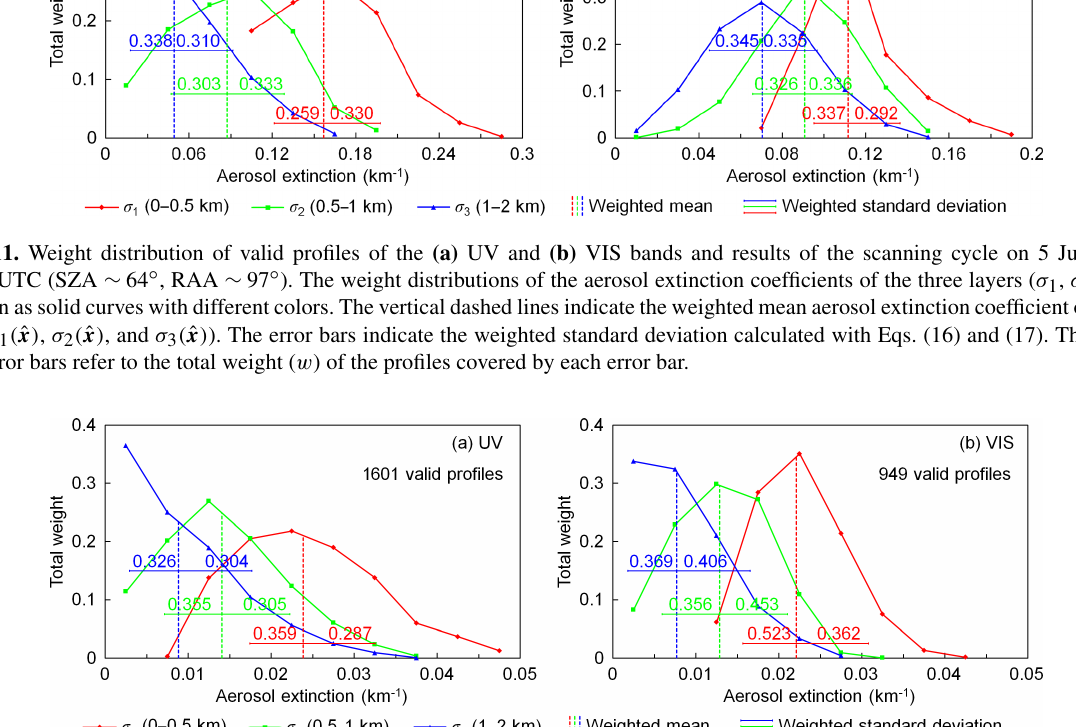
Figure 12. Same as Fig. 11, but for the scanning cycle on 7 December 2015 at ∼ 13:55UTC (SZA ∼ 79 ◦ , RAA ∼ 39 ◦